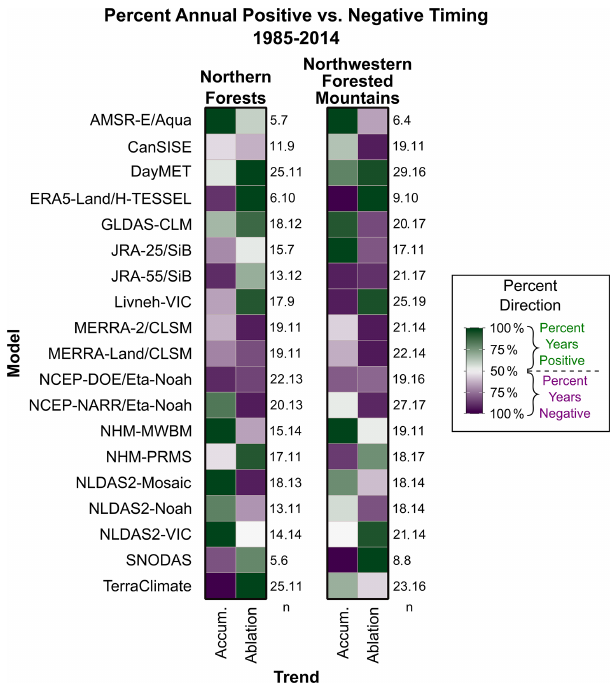
Figure B4. Heat maps summarizing the annual relative timing values of SWE accumulation (accum.) and ablation from Fig. B3 for two ecoregions. Grid cells are colored by the percentage of years that have a positive relative timing (green) or by the percentage of years that have a negative relative timing (purple), whichever is